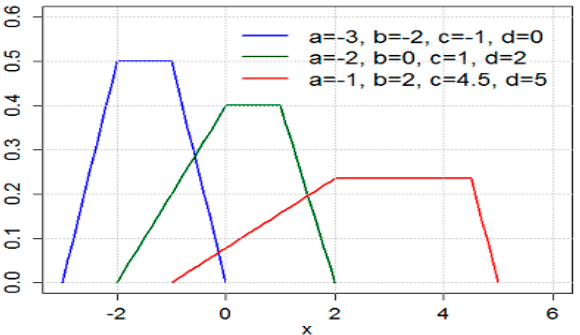
Figure 10. Examples of trapezoidal distribution function with different values.